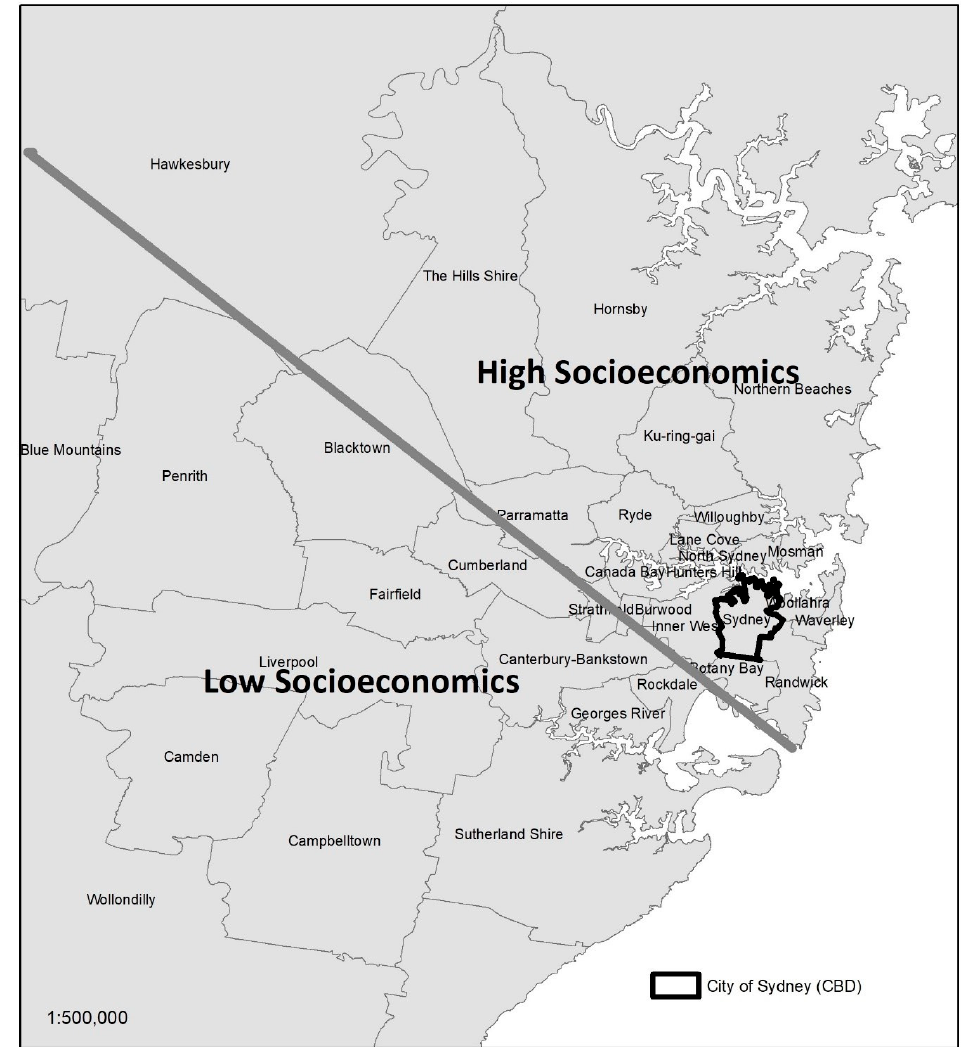
Figure 6. The east–west urban divide in Greater Sydney. Source: authors’ own. Data from the Australian Bureau of Statistics (ABS) 2016 digital local government boundaries.